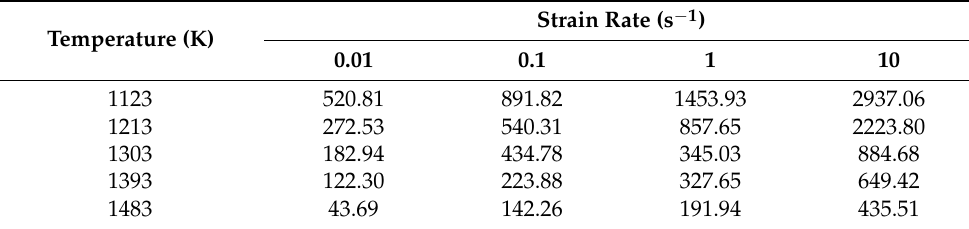
Strain Rate (s − 1